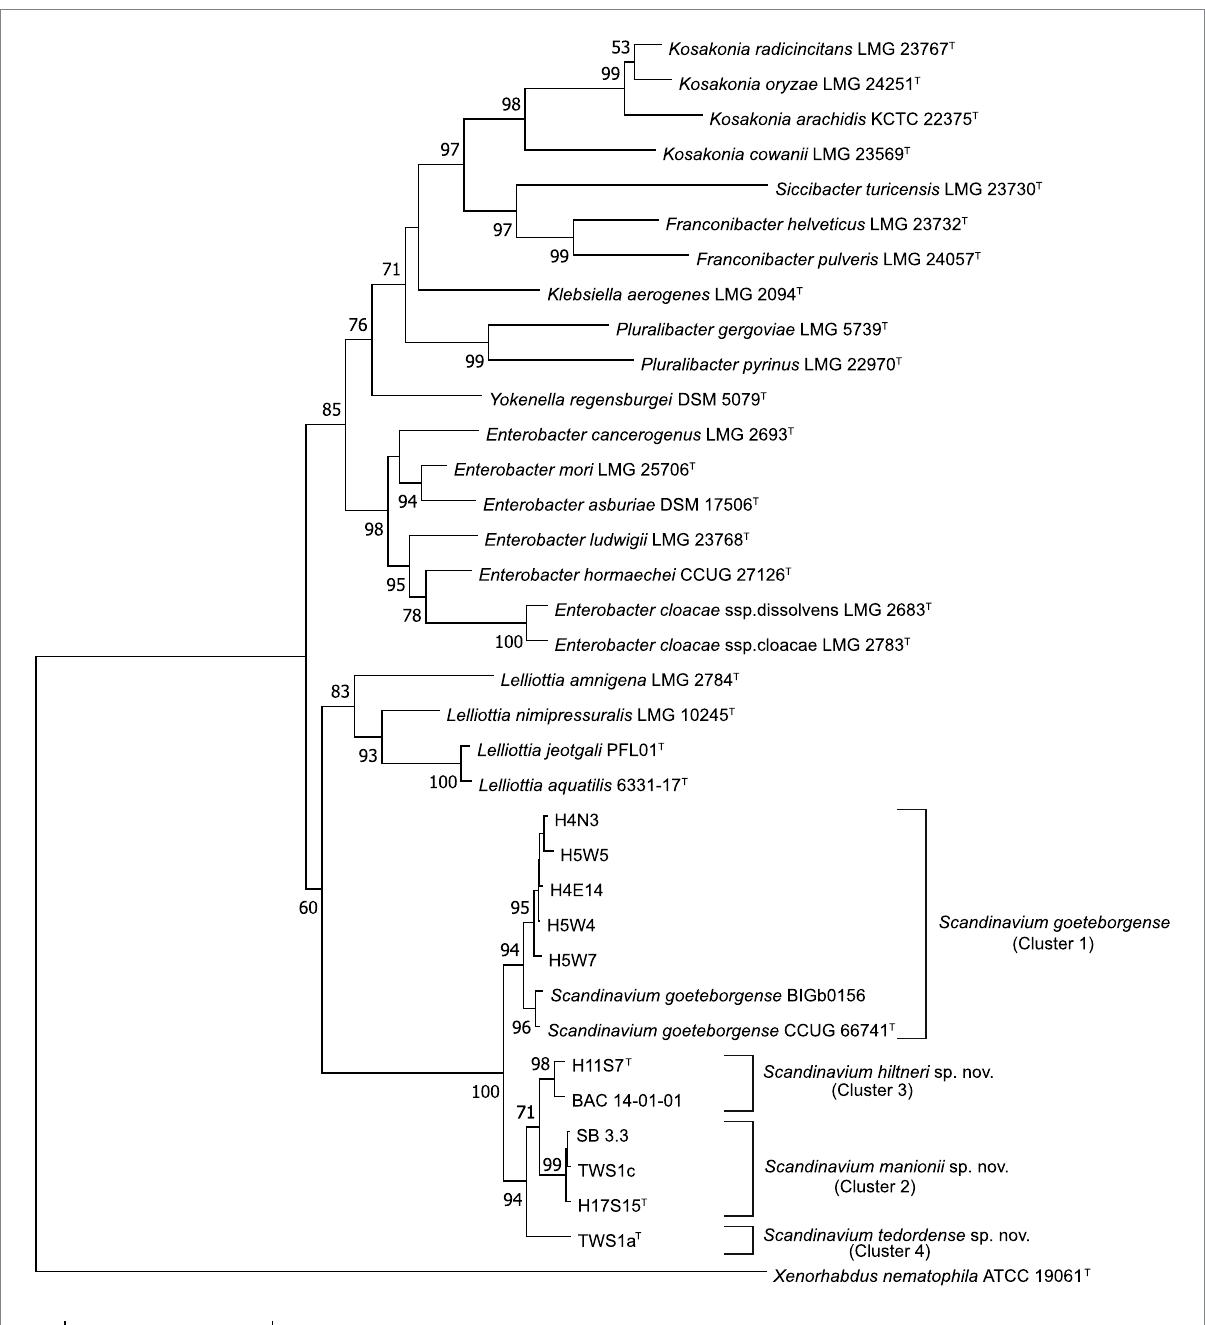
FIGURE 1 Maximum likelihood tree based on the concatenated partial gene sequences of infB, atpD , and gyrB . Sequences included are for the genus Scandinavium , the three proposed novel species, Scandinavium hiltneri sp. nov. , Scandinavium manionii sp. nov. and Scandinavium tedordense sp. nov., as well as close phylogenetic neighbours. Xenorhabdus nematophila (ATTCC 190601 T ) was included as the outgroup. 1000 replicate bootstrap values (> 50%) are shown at branch points. The scale bar indicates the number of substitutions per site. Type strains are denoted via T